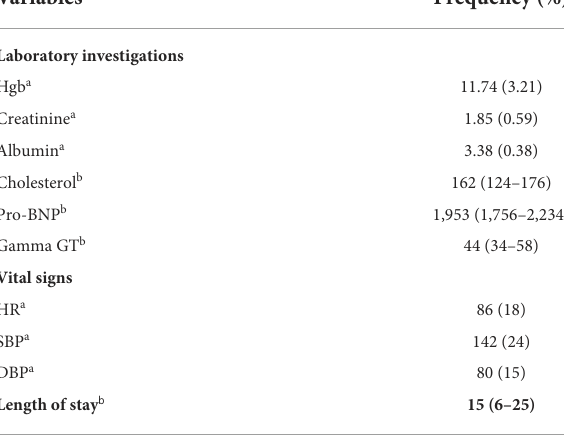
TABLE 3 Laboratory investigations, physiological, and other parameters.